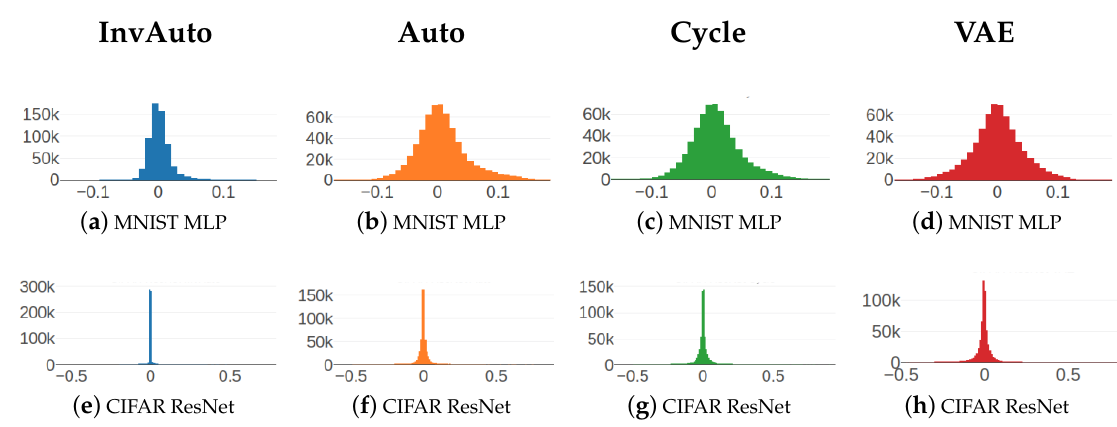
Figure 4. The histograms of cosine similarity of the rows of E for InvAuto ( a , e ), Auto ( b , f ), Cycle ( c , g ), and VAE ( d , h ) on MLP and ResNet architectures and MNIST and CIFAR datasets.